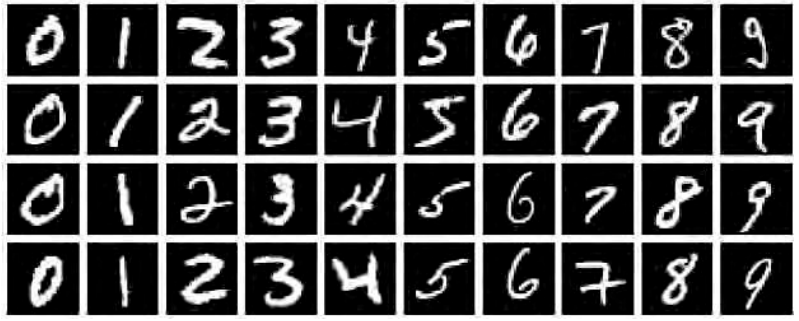
Figure 4. Example of MNIST handwritten dataset.